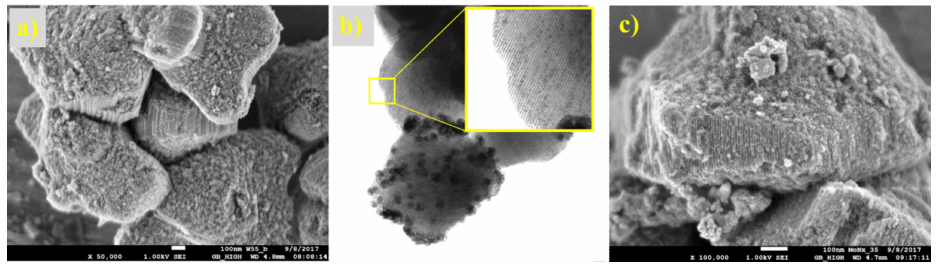
Figure 18. Microphotographs of the samples supported on SBA-15 for ( a ) SEM of the carbide sample (50,000 × ), ( b ) TEM of the carbide sample, and ( c ) SEM of the nitride sample (100,000 ×